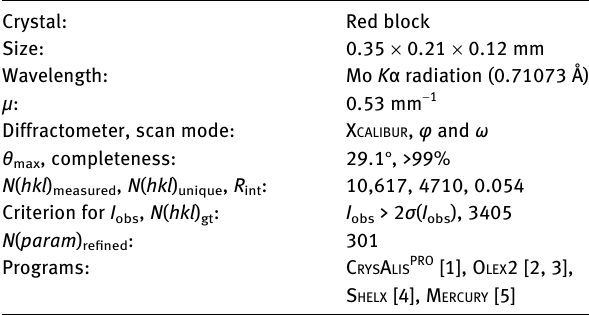
Table  : Data collection and